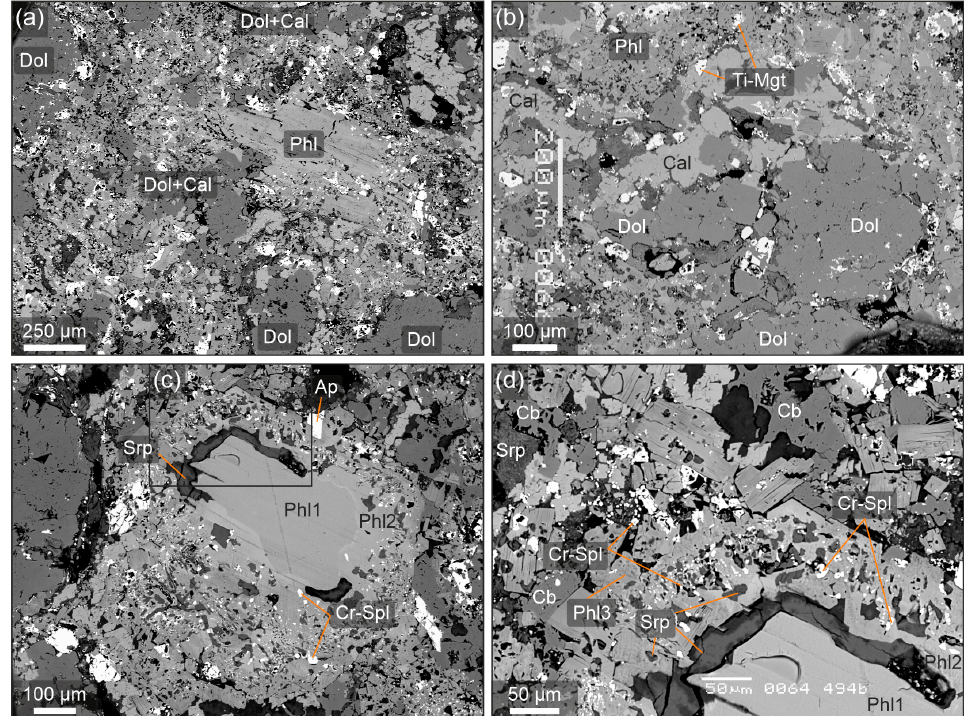
Figure 6. BSE images of carbonate-bearing coherent porphyritic kimberlite in the Kepino sills (sample 494b-715-1/2): ( a ) large phlogopite grains and carbonate segregations set in the fine-graded matrix of carbonate, serpentine, phlogopite, oxides, and apatite; ( b ) the carbonate segregations consist of calcite, and dolomite grains; ( c , d ) zoned phlogopite phenocryst consist of (i) a relict core zone with wavy resorbed boundaries (Phl1); (ii) a metasomatic transitional zone (with fine-grained inclusions of spinel) (Phl2) that indicates interaction of the core (Phl1) with kimberlitic magma; (iii) phlogopite (Phl3) with poikilitic inclusions of carbonate, spinel, magnetite, and serpentine (see